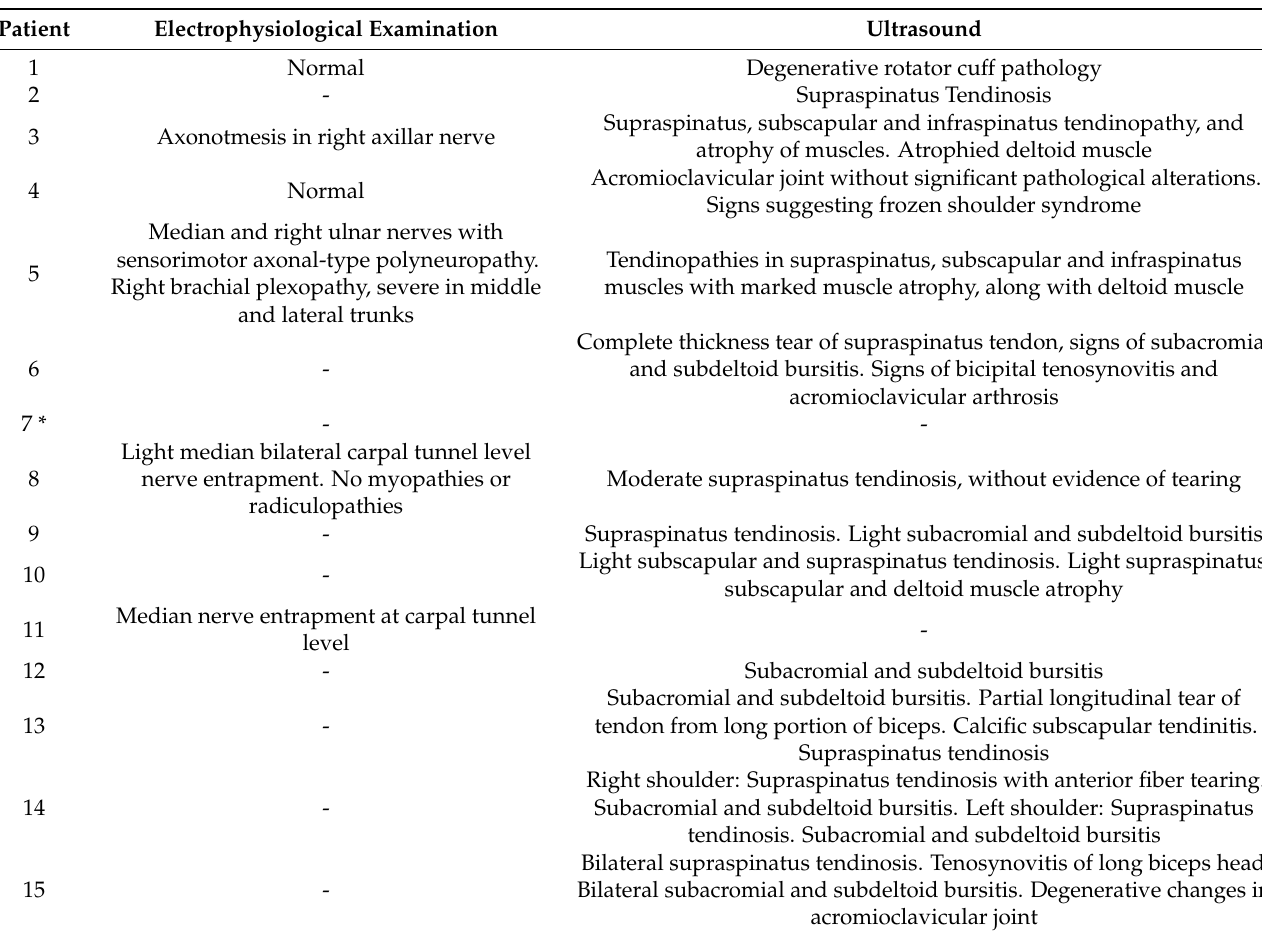
Table 3. Results of the upper limb electrophysiological examination and shoulder ultrasound.